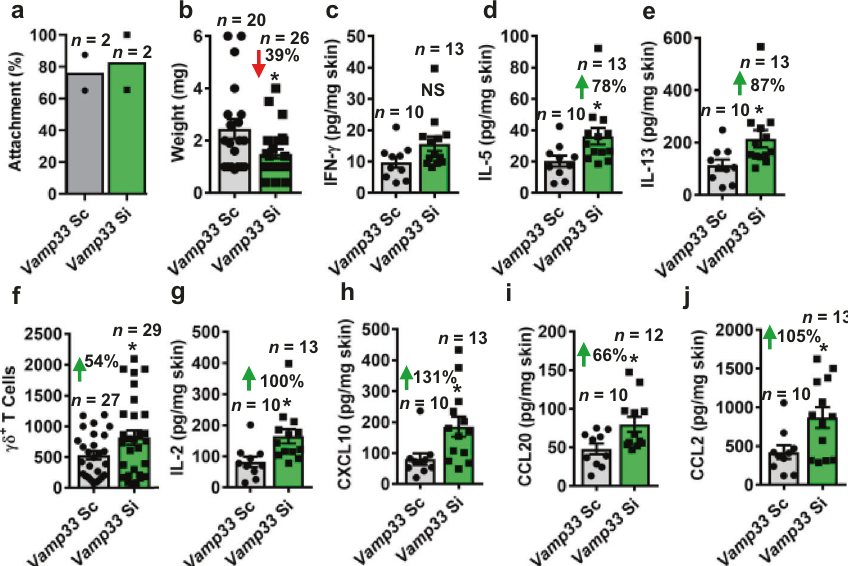
Fig. 3 Tick EVs affect the skin resident immune environment. a Attachment and b weight of I. scapularis ticks microinjected with vamp33 small interfering ( Vamp33 si ) (green) ( n = 26) or scrambled ( Vamp33 sc ) (gray) ( n = 20) RNA on C57BL/6 mice ( n = 2 each treatment) after 3 days of feeding. Mean ± standard error of the mean (SEM) are plotted. Data represent two independent experiments. Statistical differences were evaluated by two-tailed t test. * p < 0.05. Effect of vamp33 si I. scapularis ticks on c interferon (IFN)- γ , d interleukin (IL)-5, and e IL-13 in the murine skin after 3 days of feeding. Increased f γδ T cells, g IL-2 and h – j chemokine release at the bite site after Vamp33 si I. scapularis fed for 3 days on C57BL/6 mice. Mean ± SEM are plotted. Cytokine and chemokine data represent a single experiment with multiple biological replicates, whereas data with skin immune cells represent three independent experiments combined. Statistical differences in d – j were evaluated by two-tailed t test. * p < 0.05. NS not signi fi cant. n number of samples. Source data are provided as a Source Data fi